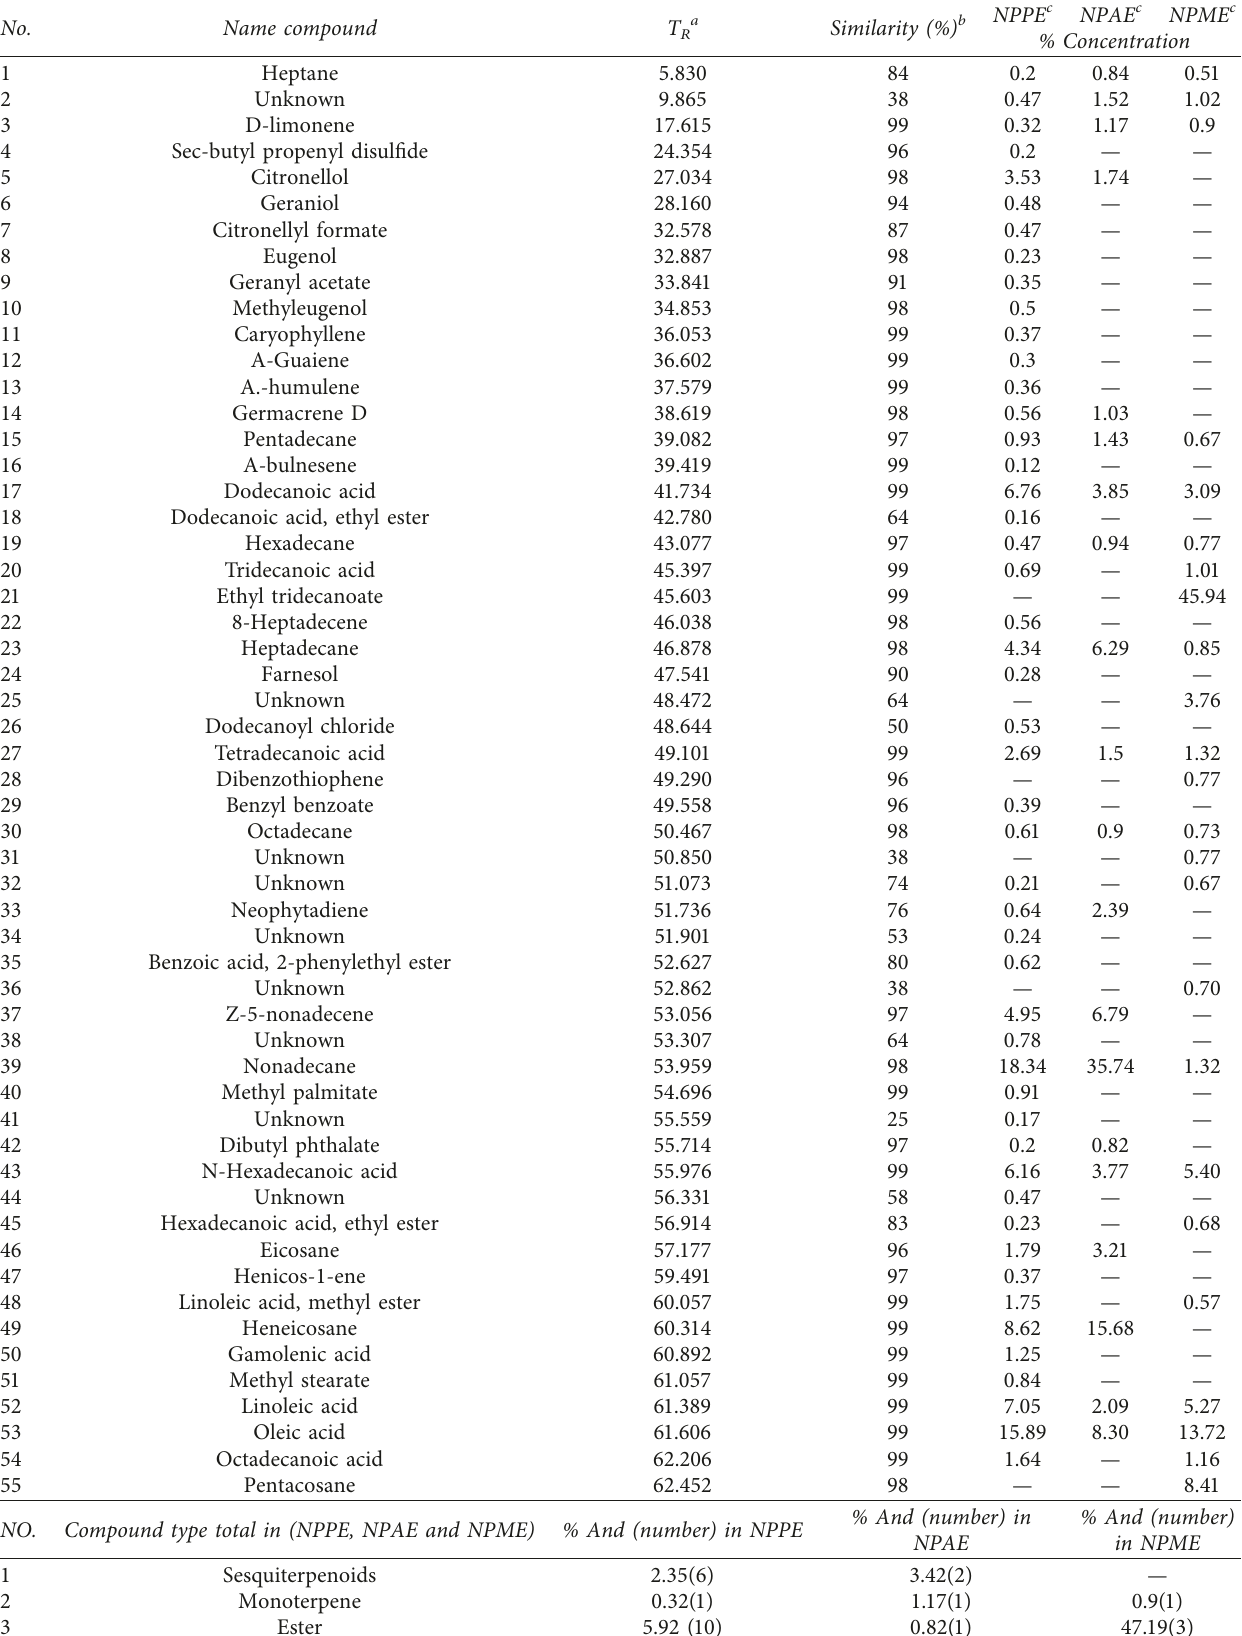
Table 6: GC-MS analysis of petroleum ether, acetone, and methanol extracts from N.